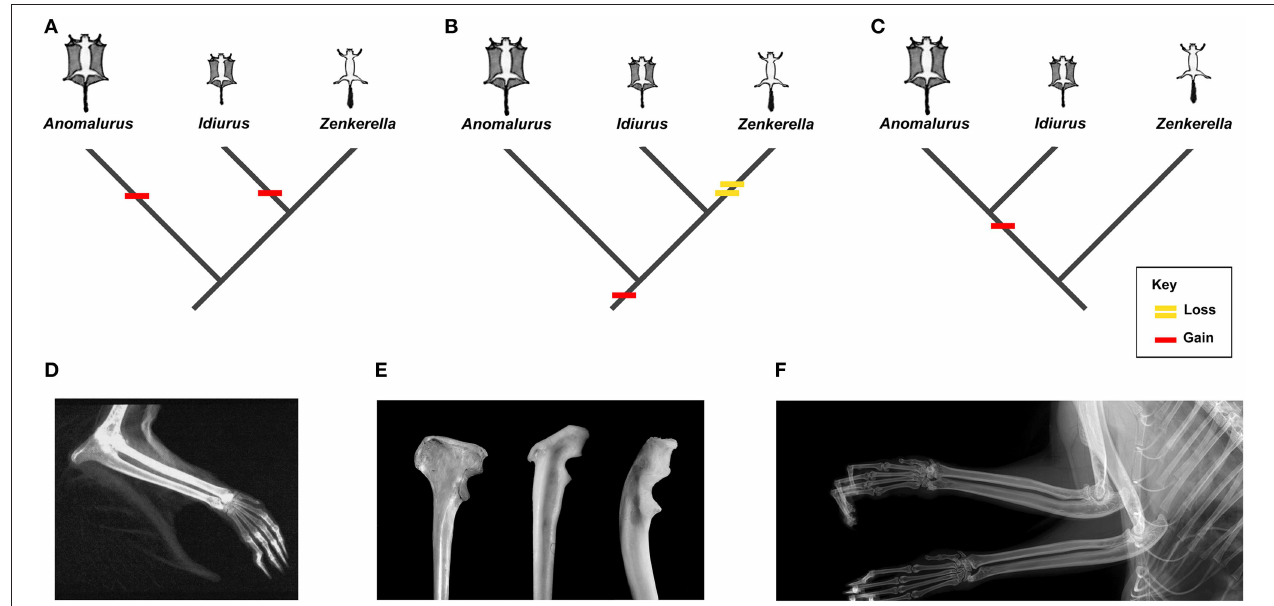
FIGURE 1 | Osteological markers and alternative interpretations of the evolution of gliding in living Anomaluridae (red bars indicate acquisition of gliding, yellow bar signifies loss of gliding). (A) cladogram depicting conventional relationships among crown anomalurids with convergent acquisition of gliding in extant Anomalurus and Idiurus ; (B) cladogram depicting conventional relationships among crown anomalurids showing early acquisition of gliding in crown anomalurids and secondary loss of gliding by Zenkerella ; (C) cladogram depicting unconventional relationships among crown anomalurids showing retention of non-volant locomotion in Zenkerella and homologous acquisition of gliding by the Anomalurus + Idiurus clade; (D) x-ray of the bones of the forearm and styliform cartilage of Anomalurus derbianus (from Jackson, 2012: 5); (E) from left to right (not to scale): Anomalurus derbianus proximal ulna from the Museum für Naturkunde (ZMB 25307), Idiurus macrotis proximal ulna from the Museum für Naturkunde (ZMB 22754), Zenkerella insignis proximal ulna from the Museum für Naturkunde (ZMB 10085); (F) x-ray of the bones of the forearm of Zenkerella insignis from the Royal Museum of Central Africa (RMCA 28806) showing the absence of styliform